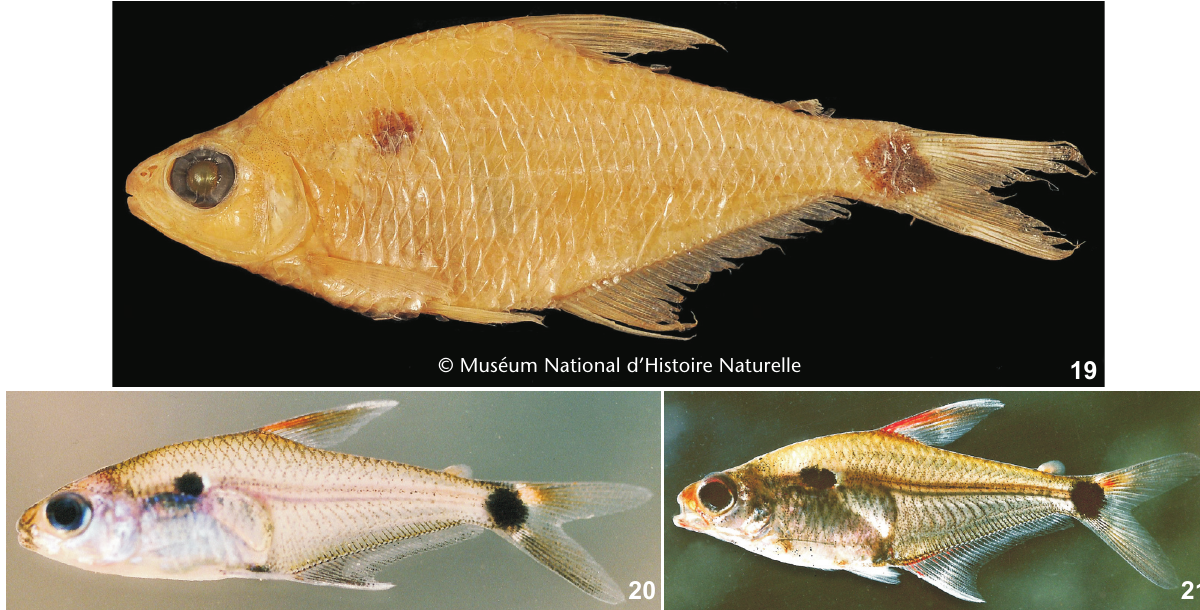
Figuras 19-21. Phenacogaster wayana sp. nov. : (19) MNHN 2003-2565, holótipo, 41,3 mm CP, Crique Japigny, Guiana Francesa; (20) exemplar vivo do Rio Mana, Guiana Francesa. Foto P.Y Le Bail; (21) exemplar vivo do Rio Maroni, Guiana Francesa. Foto